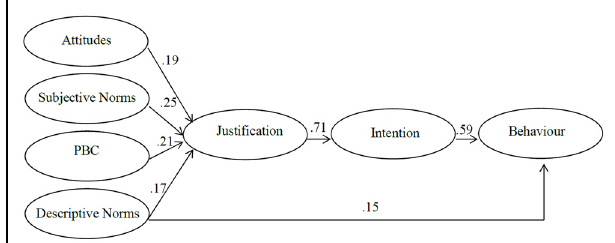
FIGURE 2 | Revised model of theory of planned behavior augmented by descriptive norms and